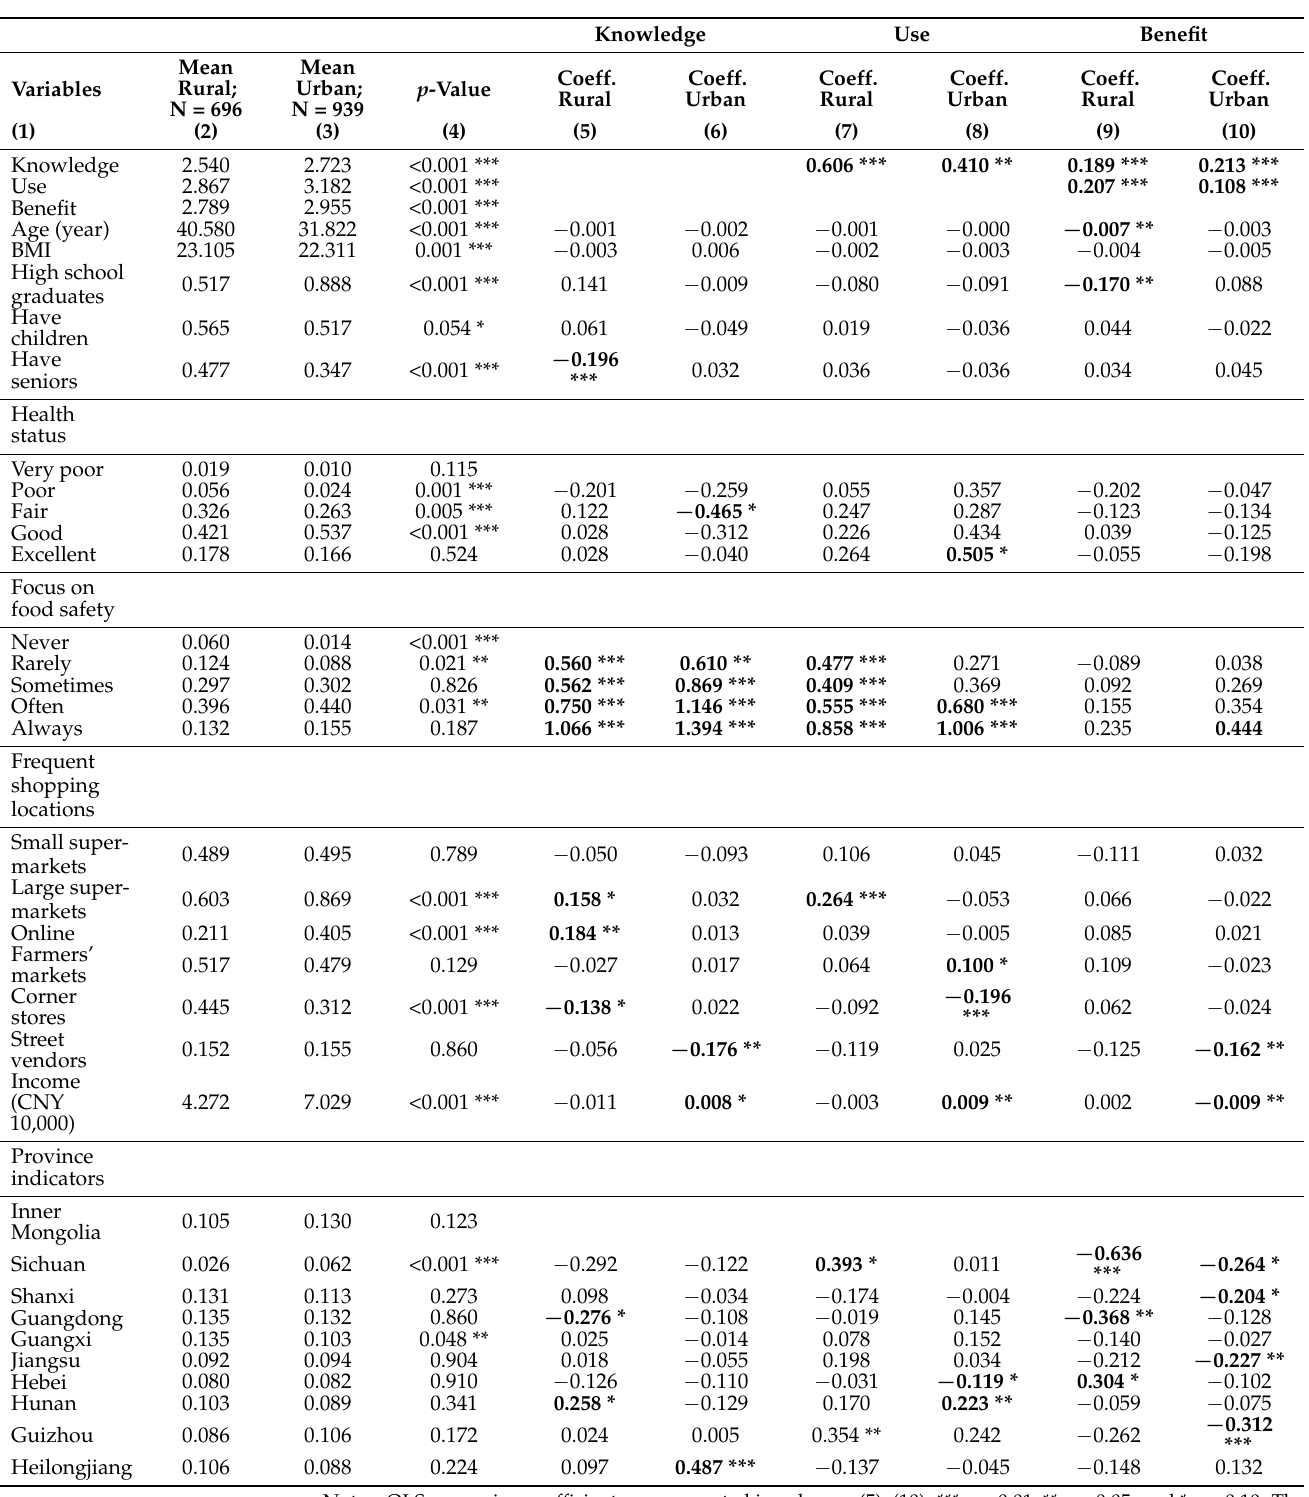
Table 3. Sample means and regression estimates for the knowledge, use and perceived benefits of nutrition labels among urban and rural